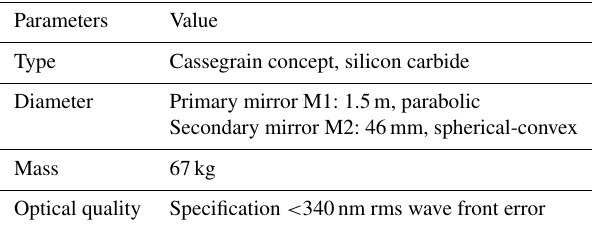
Table 1. Aeolus telescope